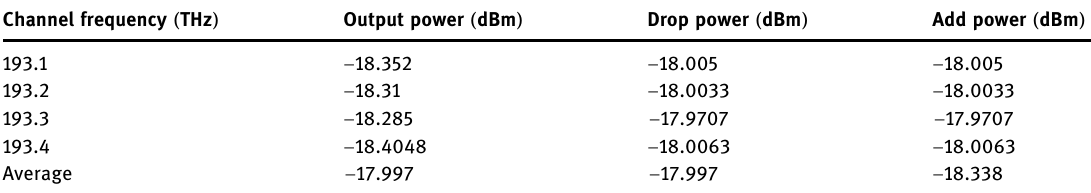
Table 1: Output, drop, and add power obtained from the electrical power meter visualizer at the receiver side Channel frequency ( THz